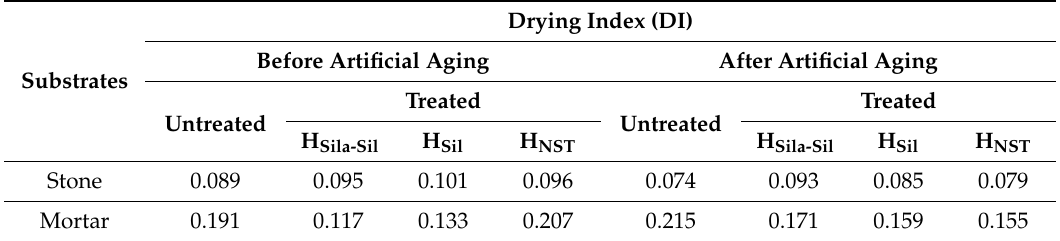
Drying Index (DI)